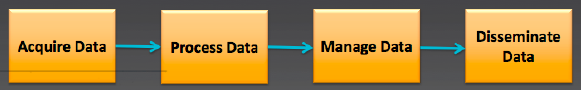
Figure 1. UAS Production Process (USGS)